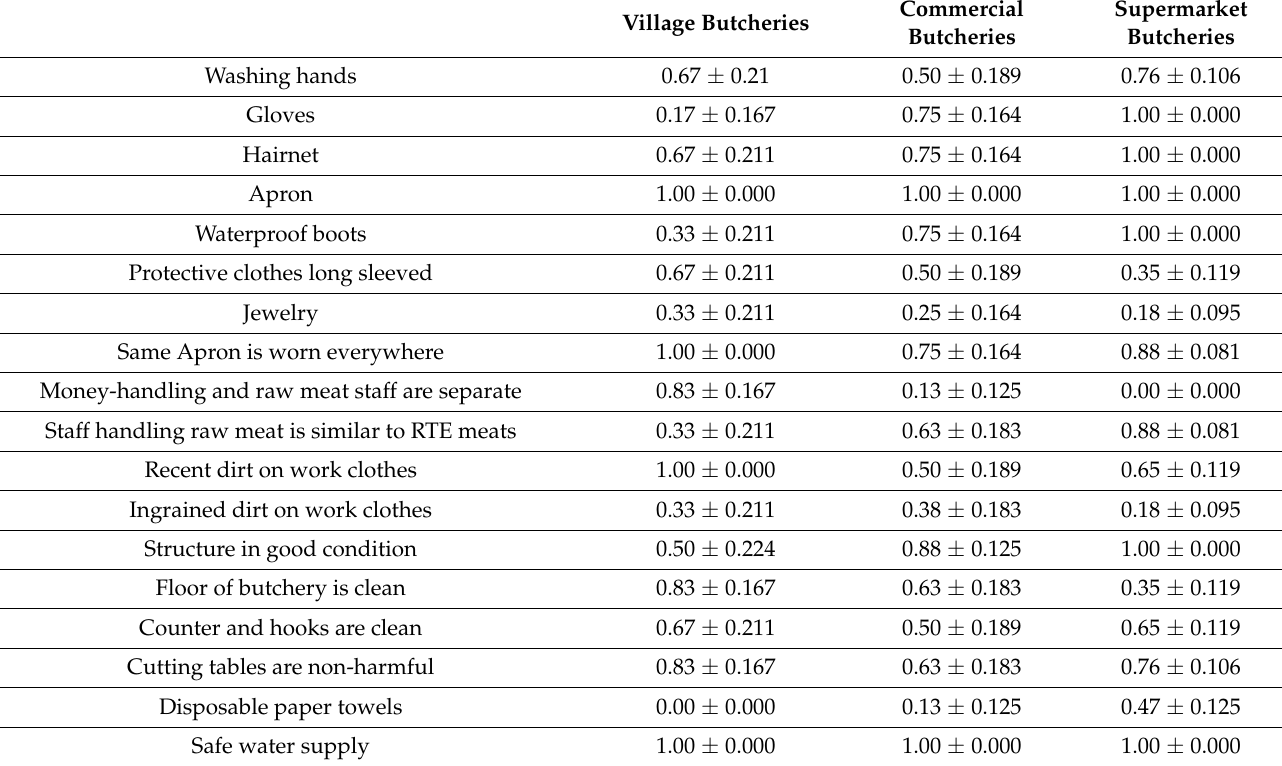
Table 4. The Mean and Standard error of meat safety practices in various butcheries and supermarkets in the Vhembe district, Limpopo, South